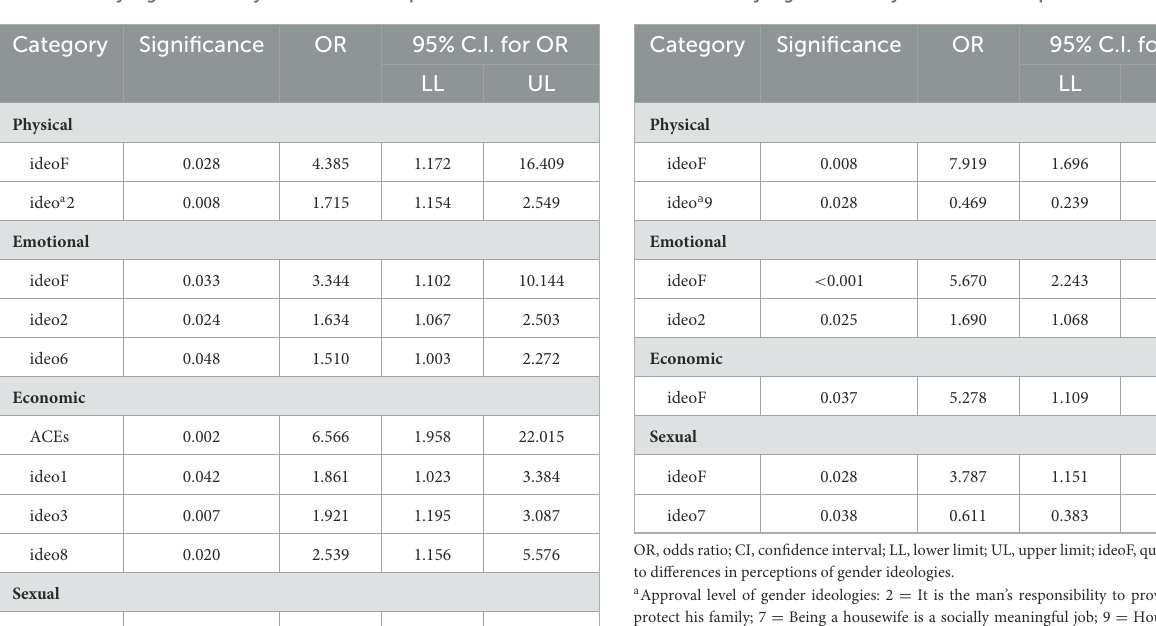
TABLE 4 Binary regression analysis results of Group 1. TABLE 5 Binary regression analysis result of Group